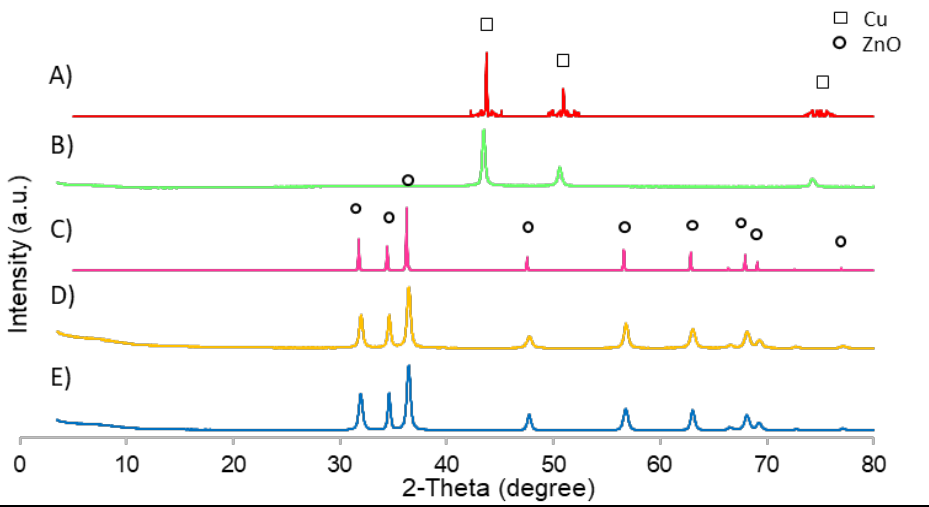
Figure 1. XRD patterns of all catalysts: ( A ) Cu nanoparticle simulation; ( B ) Cu nanoparticles; ( C ) ZnO nanoparticle simulation; ( D ) ZnO nanoparticles with PVP; ( E ) ZnO nanoparticles.